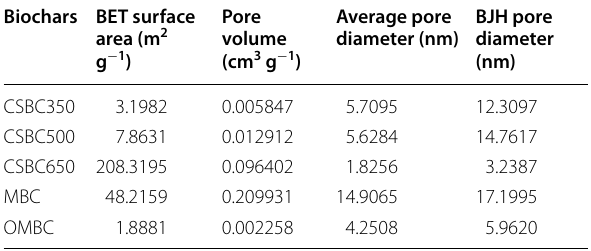
Table 1 BET surface area and pore size of biochars Biochars BET surface area (m